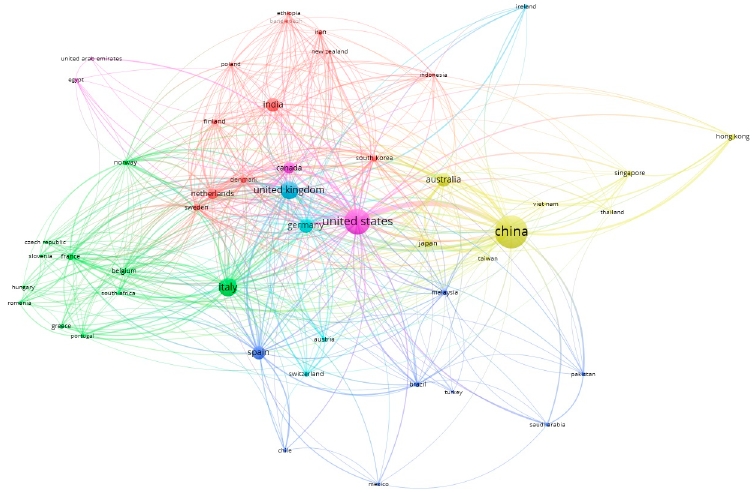
Figure 8. Collaborative network between countries.